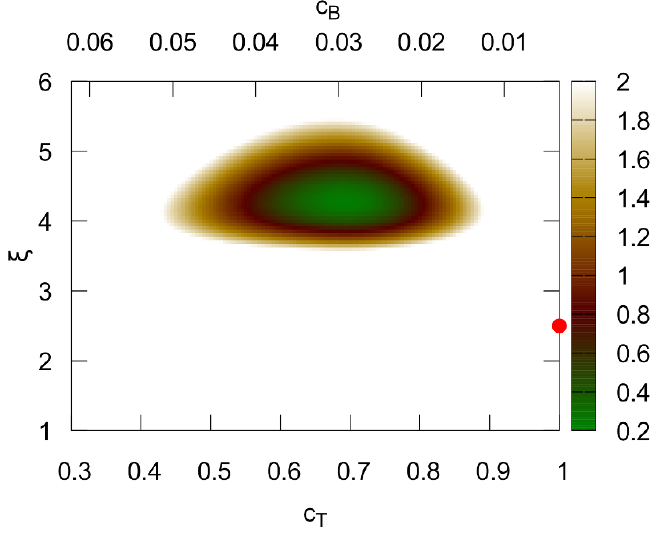
Figure 5 . The normalized deviation (cid:1) R of the QCD and N = 4 SYM results for p T =p L , plotted as a function of the SYM charge rescaling factor (cid:24) and the value of c T de(cid:12)ning the renormalization point (with c B correspondingly (cid:12)xed to lie along the QCD valley of near-universality). The red dot indicates the high temperature motivated choice (cid:22) = T and (cid:24) = 2 : 5.